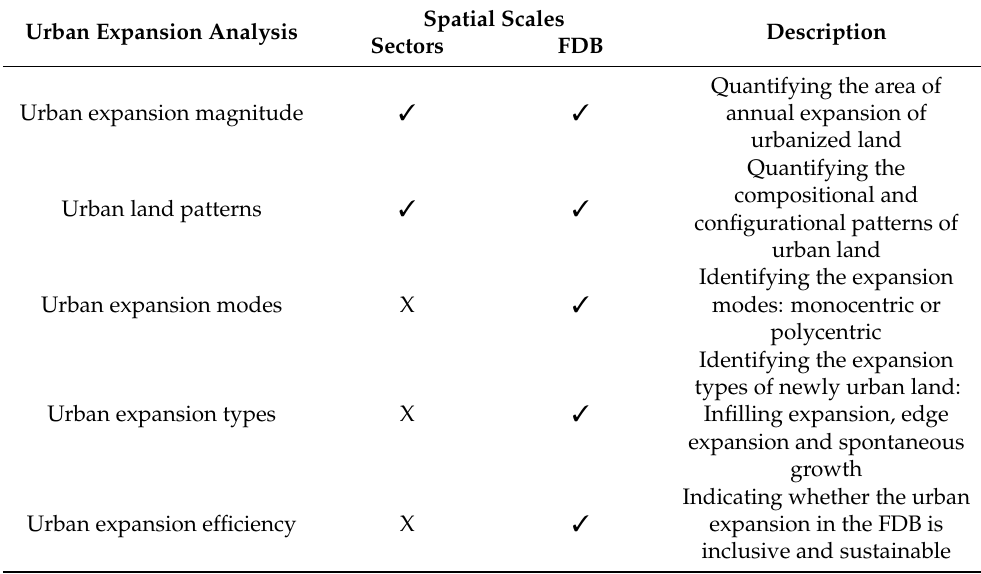
Indicating whether the urban expansion in the FDB is inclusive and